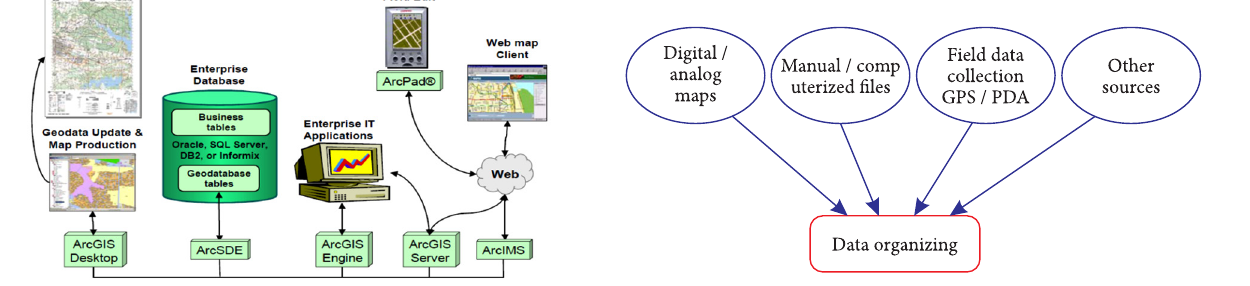
Figure 5. The ArcGIS family of products (ESRI, 2004) Figure 6. Different data